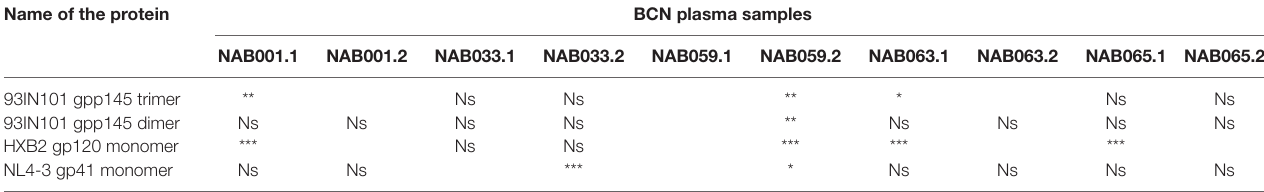
TaBle 3 | ELISA with different forms of HIV-1 envelope protein. name of the protein